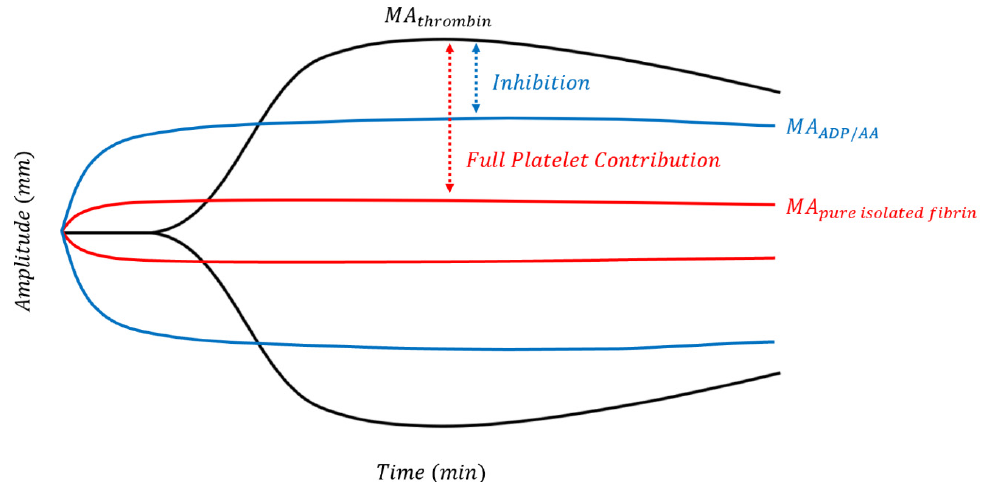
Figure 4. The TEG ® PlateletMapping assay is composed of four tests, starting with a standard kaolin TEG ® (black line; corresponds to Cup 1 of Figure 3) that depicts maximally activated platelets and full clot strength potential (MA thrombin ). The clot strength of pure fibrin (red line; corresponds to Cup 2 in Figure 3) is isolated after blockage of all thrombin in the second test. Platelets are then activated in the third and fourth tests through either their ADP or AA receptors, and clot strength of platelets activated at either receptor (blue line; corresponds to Cups 3 & 4 in Figure 3) is evaluated by the proximity of the stimulated platelet as a percentage of MA thrombin [128]. The platelet inhibition in response to the agonist is calculated from platelet aggregation: [(MA ADP − MA fibrin )/(MA thrombin − MA fibrin ) × 100] and % inhibition = (100 − %aggregation) [109].